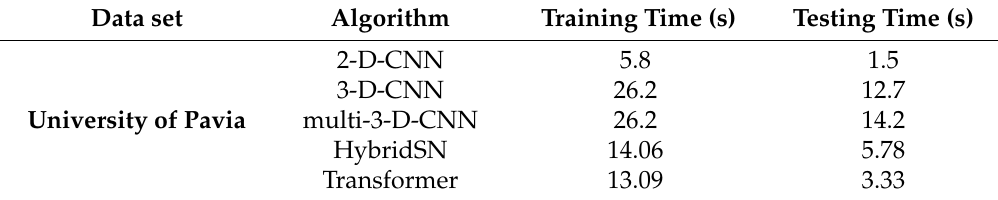
Table 15. Running time of the five methods on the University of Pavia data set.